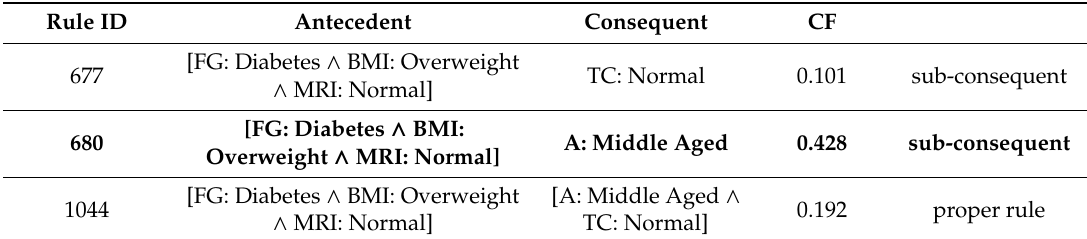
Table 7. Example of subsumption rules (proper rule and its sub-consequences)